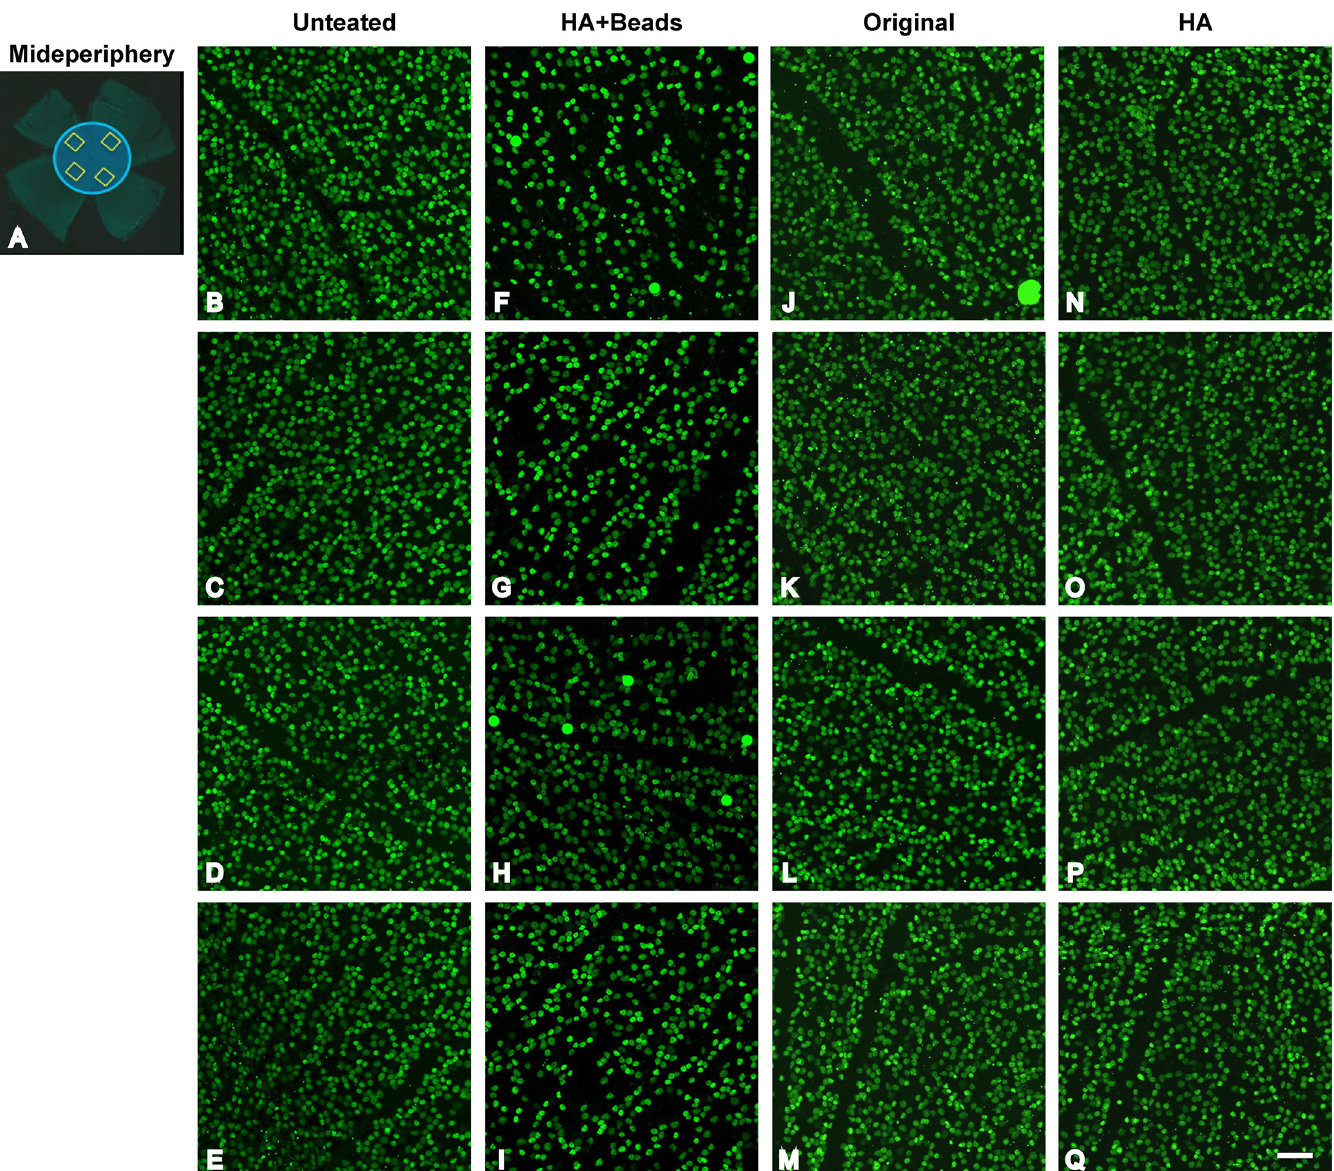
Fig 3. Retinal ganglion cell (RGC) damage in the midperipheral retina from each experimental group. (A) Damage assessment approach. After immunostaining whole retinal flatmounts with Brn-3a, a RGC-specific marker, four areas in the midperiphery (yellow outlined rectangles in the blue circle) were selected to determine RGC density. (B-E) Confocal microscopic images from the selected retinal areas in normal, untreated C57BL/6J mice immunostained with Brn-3a. Confocal images from the hyaluronic acid (HA) + beads group (F-I), the original method group (J-M), and the HA group (N-Q) at 30 days after injection, respectively. Scale bar = 50 μ m.